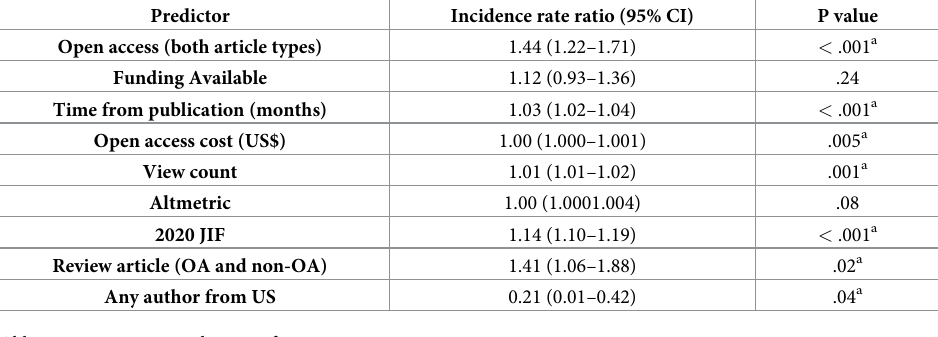
Table 3. Negative binomial regression output reporting independent variable effects on citation count in